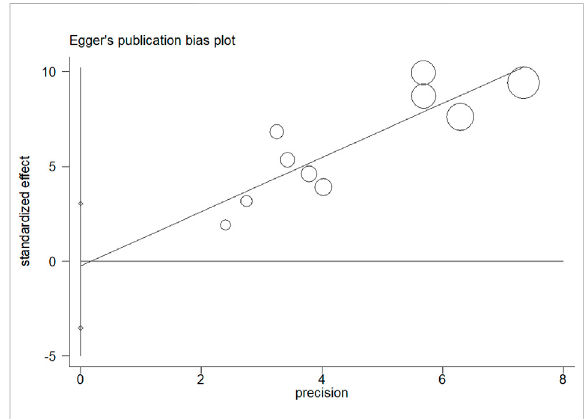
FIGURE 9 The result of publication bias for the assessment of JCR at 6 months by Egger test. JCR, jaundice clearance